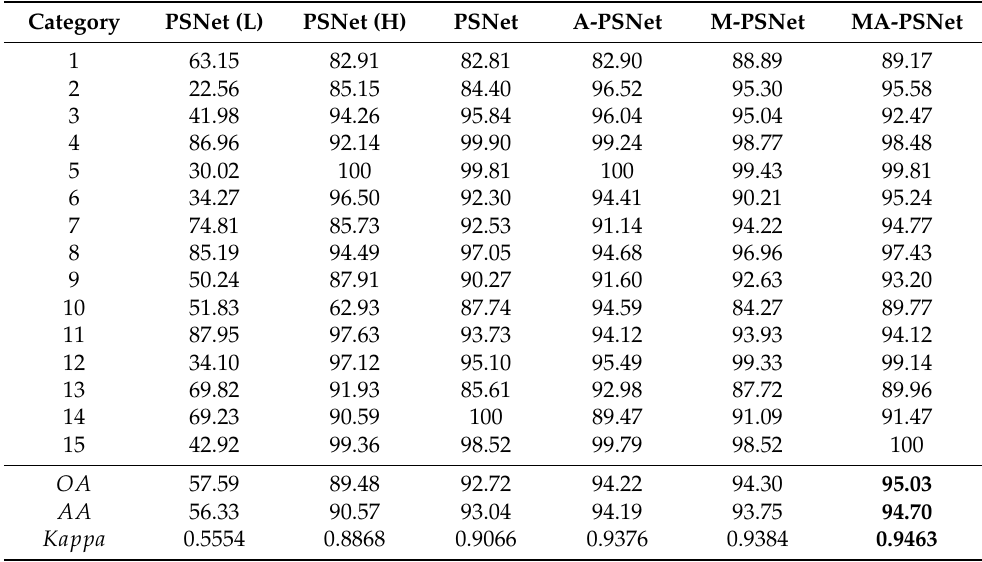
Table 3. Houston 2013: Classification accuracies for per class, OA , AA (in %), Kappa coefficient (is of no unit).